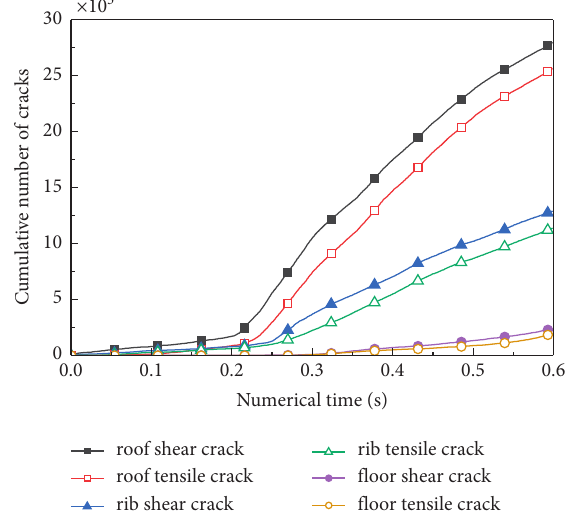
Figure 11: Variation of cumulative crack number under mine earthquake disturbance.